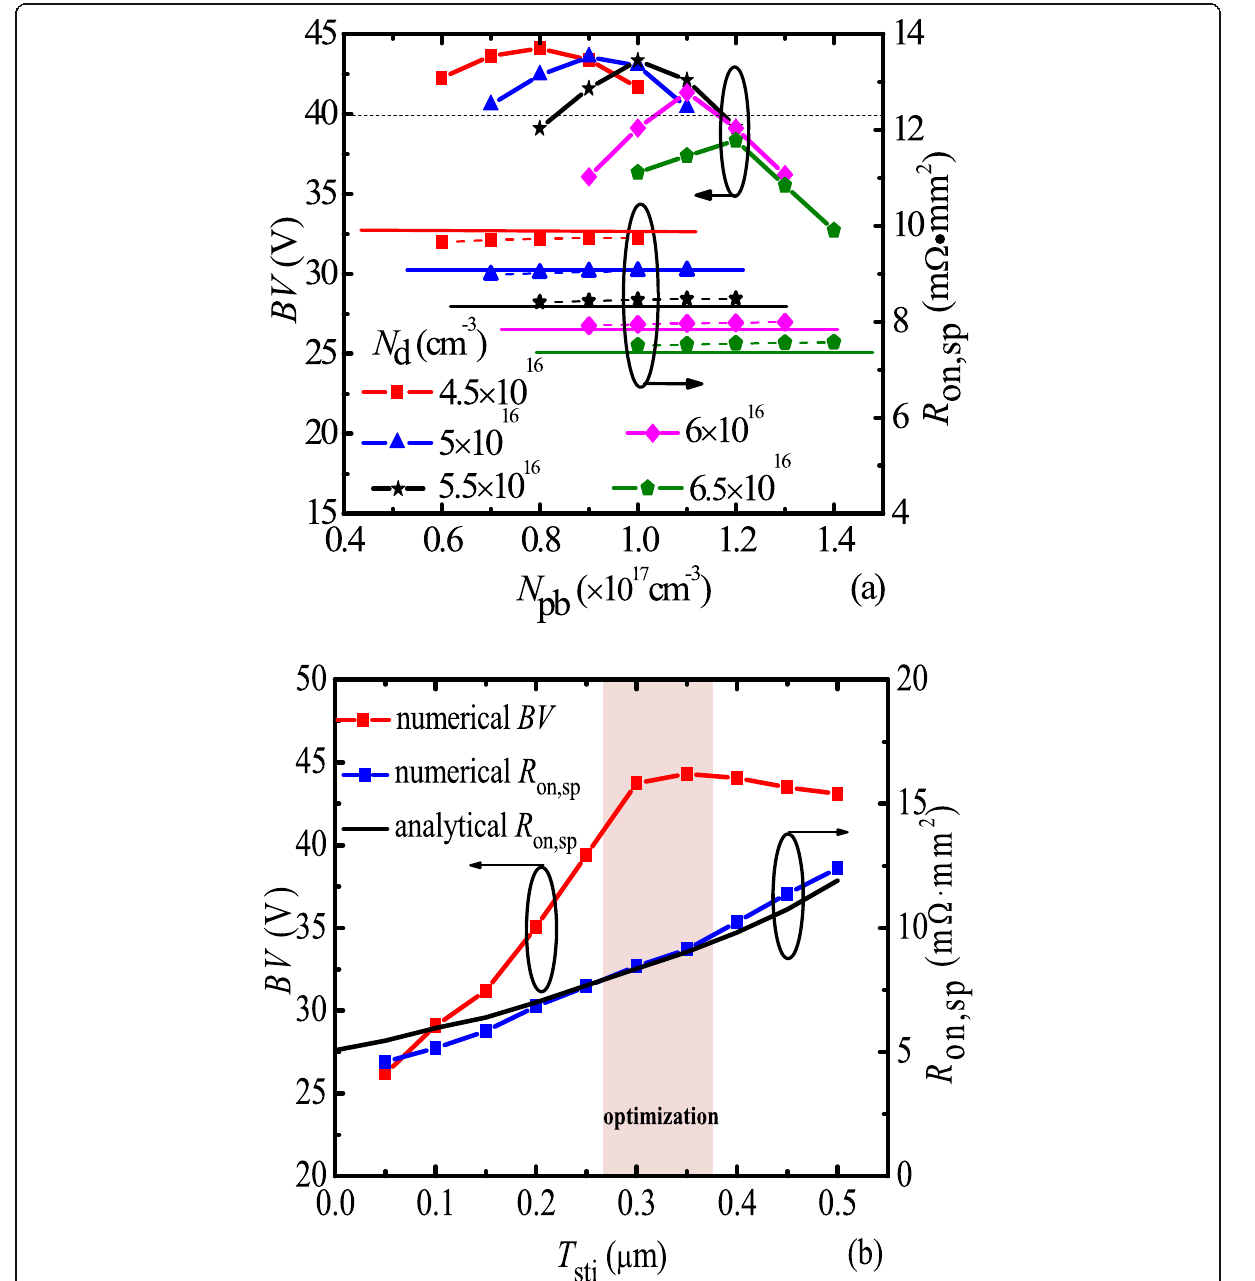
Fig. 5 a Numerical (dotted line) and analytical (solid line) BV and R on,sp as functions of N pb for different N d . b Numerical (dotted line) and analytical (solid line) BV and R on,sp as functions of T Figure 4b shows electric field distribution at the surface and the P-buried/N-drift junction interface. For opti- mized conventional LDMOS, the breakdown occurs usu- ally at the N-drift/P-buried interface. For the proposed LDMOS, the junction of N-drift/P-sub replaces the junc- tion of N-drift/P-buried to relax the vertical electric field and extend depletion region, which results in a higher BV while maintaining low R . d